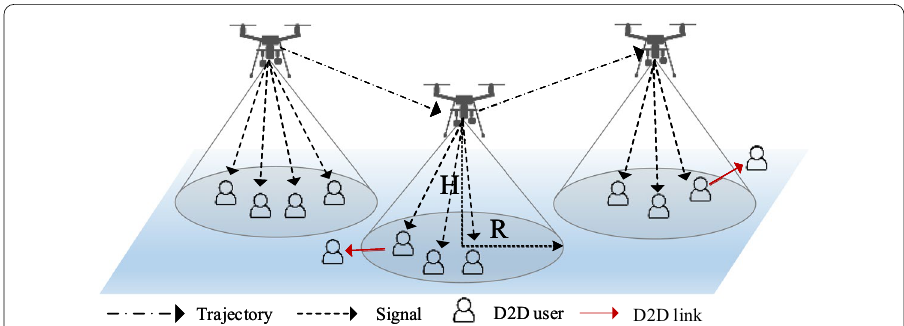
Fig. 1 A UAV-based wireless emergency communication system, where a UAV acts as a flying BS and GTs appear as D2D